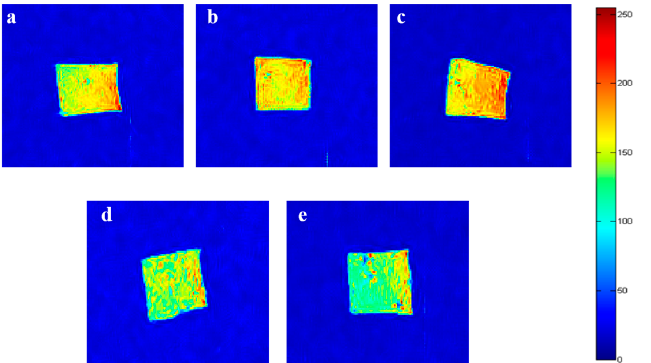
Figure 7. Proton density-weighted images of extrudates at the WG to PPP ratio of 0:100 ( a ); 30:70 ( b ); 50:50 ( c ); 70:30 ( d ); and 100:0 ( e ).